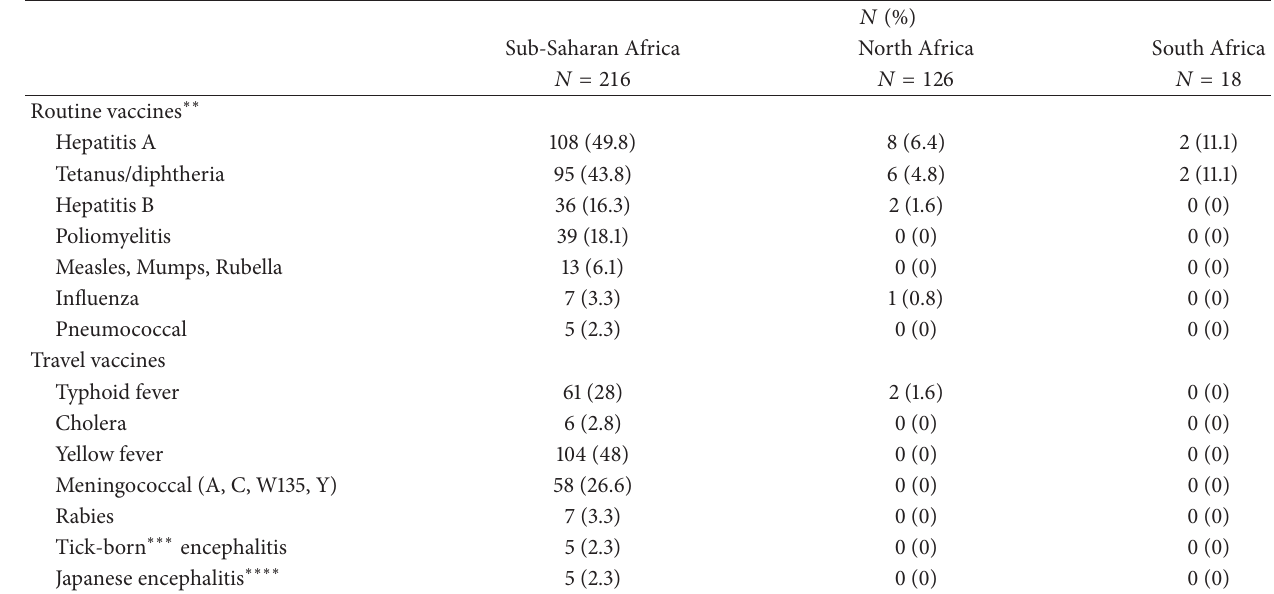
Table 2: Vaccine prophylaxis according to destination ∗ .